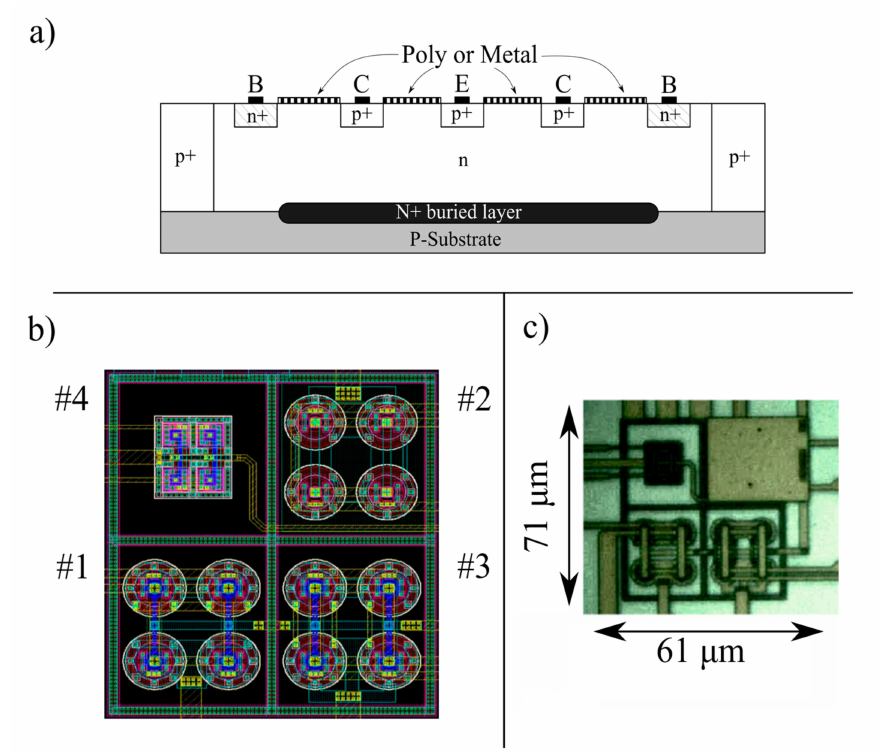
Figure 7. ( a ) Cross-section of a lateral BJT with a poly or a metal layer covering the BJT above the base region. ( b ) Layout of four prototype designs: BJT #1 is of circular shape with a poly layer above the base region. BJT #2 is a circular shape, but instead, metal covers the base region. BJT #3 is a Darlington pair transistor based on BJT #1. The BJT #4 has a poly-covered square shape. The BJT #4 design was also fabricated in 180 nm technology as BJT #5. ( c ) Microphotograph of the fabricated designs corresponding to the layout in ( b